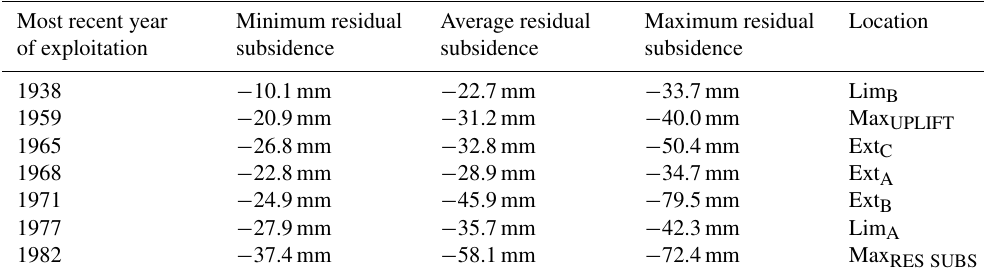
Table 5. Information on residual subsidence of the locations considered in Tables 3 and 4, reordered as a function of the most recent exploitation